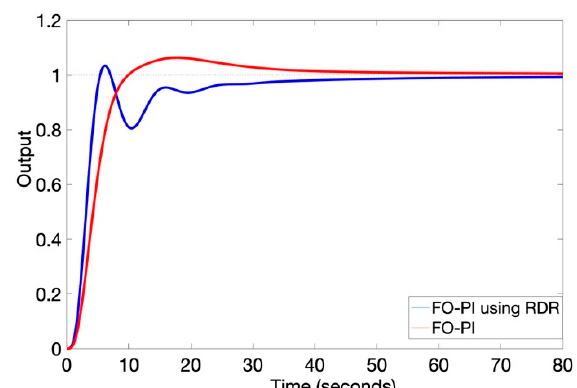
Figure 17. Reference tracking results for higher-order process ( red line – FO-PI designed by Gude 2010).